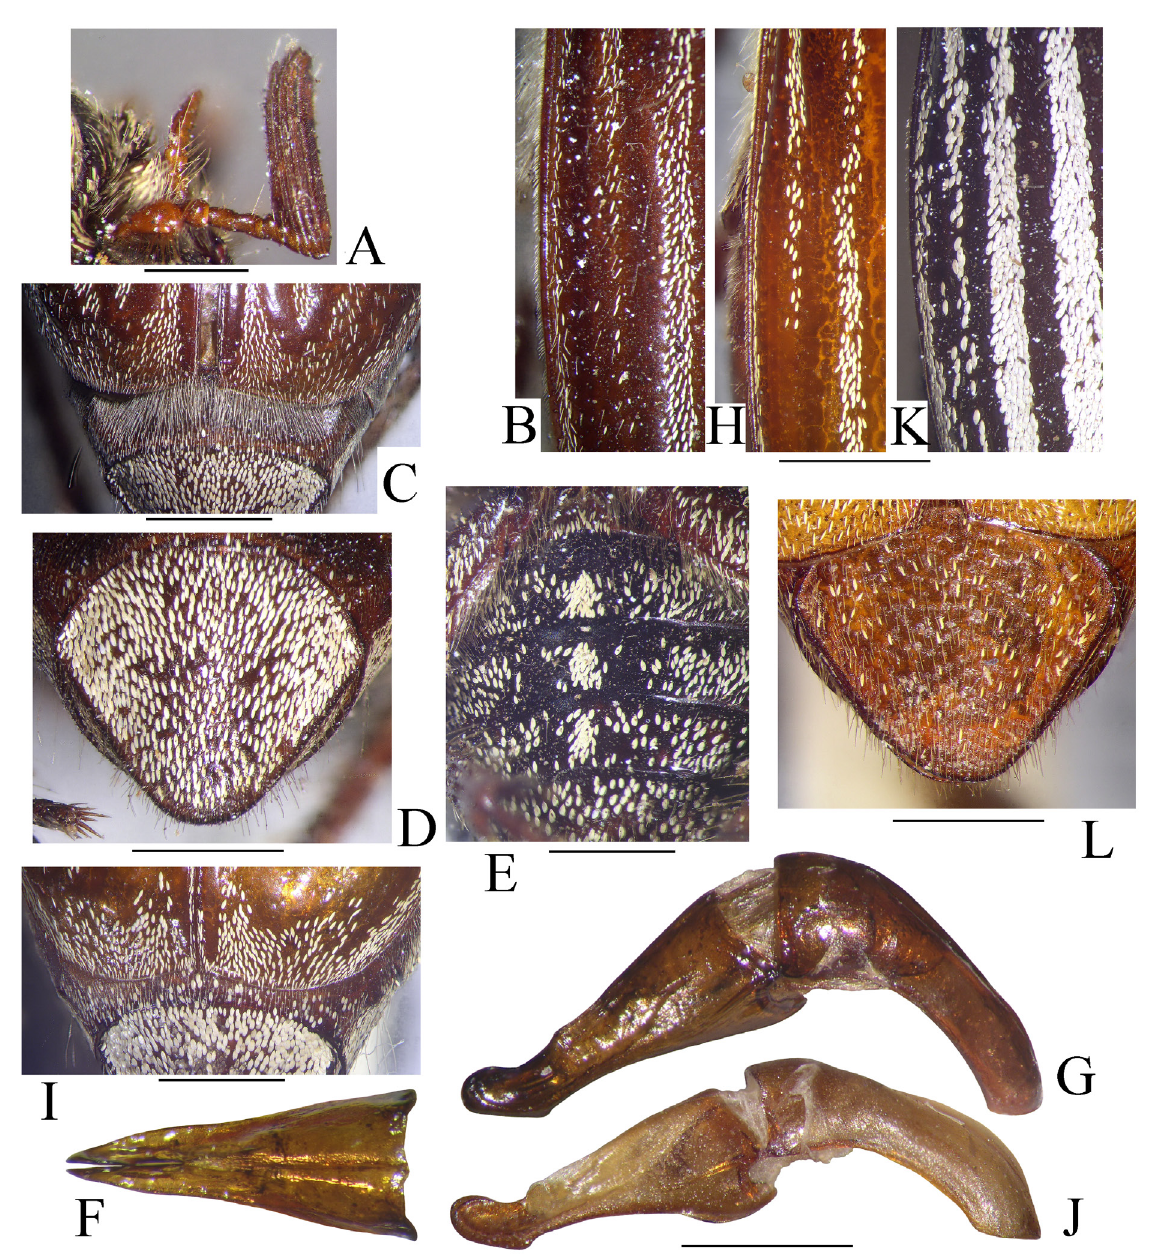
Fig. 2. A–G . Engertia allolepis sp. nov., holotype, ♂ (MNHN). A . Antenna. B . Lateral part of the elytron. C . Apical margin of elytra and propygidium. D . Pygidium. E . Abdominal ventrites 2–4. F . Parameres, dorsal view. G . Aedeagus, lateral view. — H–J . E. papuana (Moser, 1913), ♂, from Sentani (cAP). H . Lateral part of elytron. I . Apical margin of elytra and propygidium. J . Aedeagus, lateral view. — K . E. amboinae (Brenske, 1897), ♂, from Ambon (MNHN), lateral part of elytron. — L . E. setifera (Moser, 1913), ♂, from Seram, pygidium (cAP). Scale bars are in common for B, H and K, and for F–G and J. Scale bars: A–B, H, K = 1.5 mm, C–G, I–J, L =